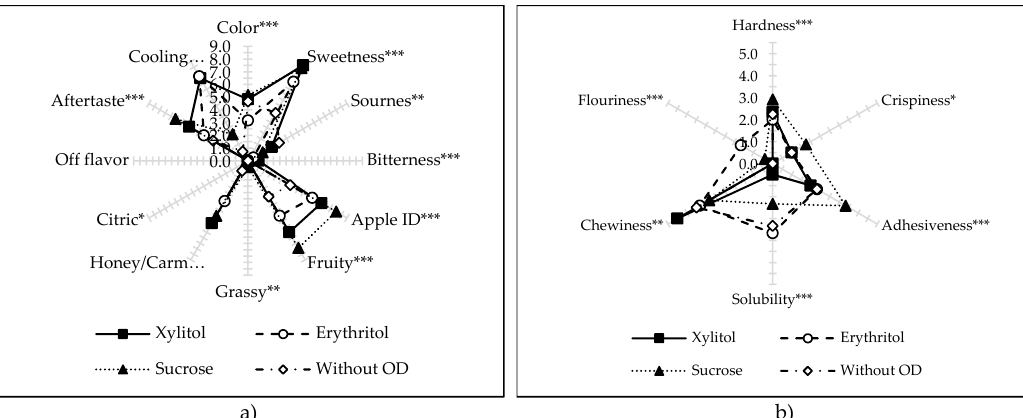
Figure 6. Descriptive sensory analysis of dried apples previously osmo-dehydrated in different solutions (or without OD): attributes for appearance, basic taste, and flavor ( a ), texture attributes ( b ). *, ** and *** – significant at p < 0.05, 0.01, and 0.001,